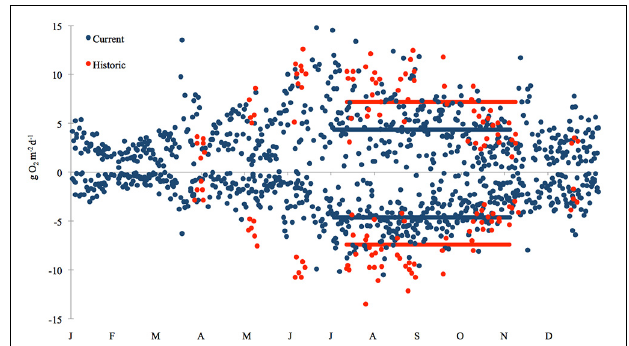
FIGURE 5 | Temporal variation in net daytime primary production (positive values) and nighttime respiration (negative values) rates at the Childs River Estuary station. The current data (blue circles) were calculated using continuous 15-min interval conductivity, temperature, and dissolved oxygen data from deployed WBNERR YSI 6600 data-sondes during 2011 and 2012 (NOAA, 2012). The historic data (red circles) are from D’Avanzo et al. (1996, Figure 1). They include data collected from Childs River Estuary over a year (Jul–Dec 1991, Jan–Jun 1992) in 10 deployments (5–25 days) of automated ENDECO model 1184 meters. The filled bars above zero indicate mean net daytime productivity rates for the sampling time frame (July–October) for the historic 7.18g O 2 m − 2 y − 1 (red bar), and current 4.36g O 2 m − 2 y − 1 (blue bar) time frames, respectively. The filled bars below zero indicate mean nighttime respiration rates for historic − 7.39g O 2 m − 2 y − 1 (red bar) and current − 4.36g O 2 m − 2 y − 1 (blue bar) time frames respectively. Differences between current and historic daily rates for both production and respiration during the July-October time frames were significant (ANOVA, p < 0 .